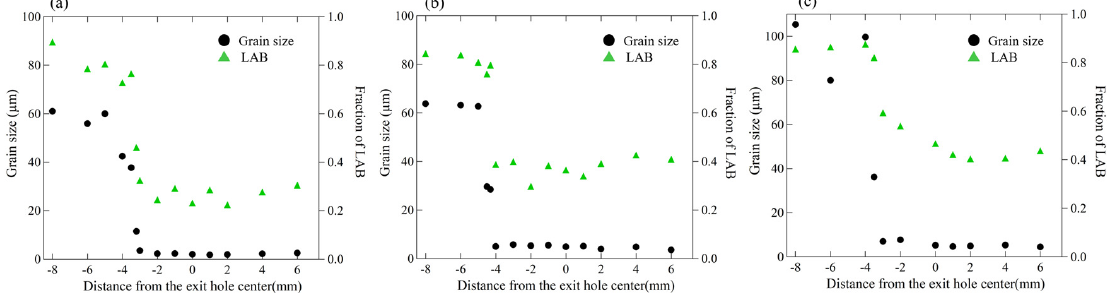
Figure 4. Average grain size and fraction of LABs for pure Al at ( a ) 0.56 T m and ( b ) 0.67 T m ; ( c ) high-purity Al at 0.50 T m .